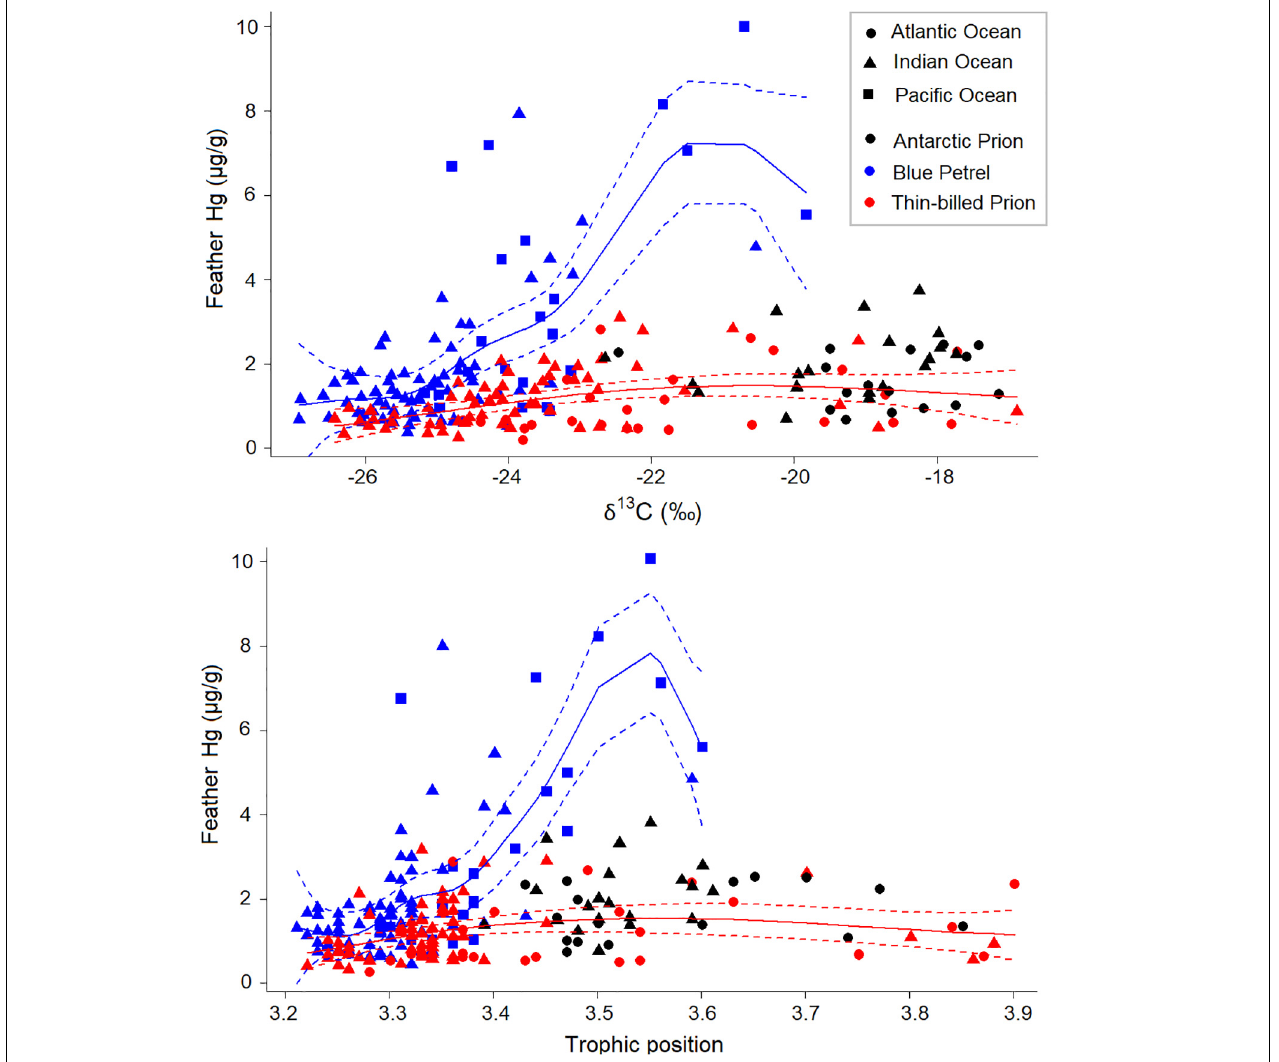
FIGURE 4 | Species-specific Generalized Additive Model (GAM) model fits for mercury values in feathers of Antarctic Prions, Blue Petrels, and Thin-billed Prions. Estimated smoothing curves for mercury values in feathers in relation to δ 13 C and trophic position (derived from δ 15 N and δ 13 C values, with 95% confidence intervals) are given where statistically significant. For GAM statistics, see Table 4